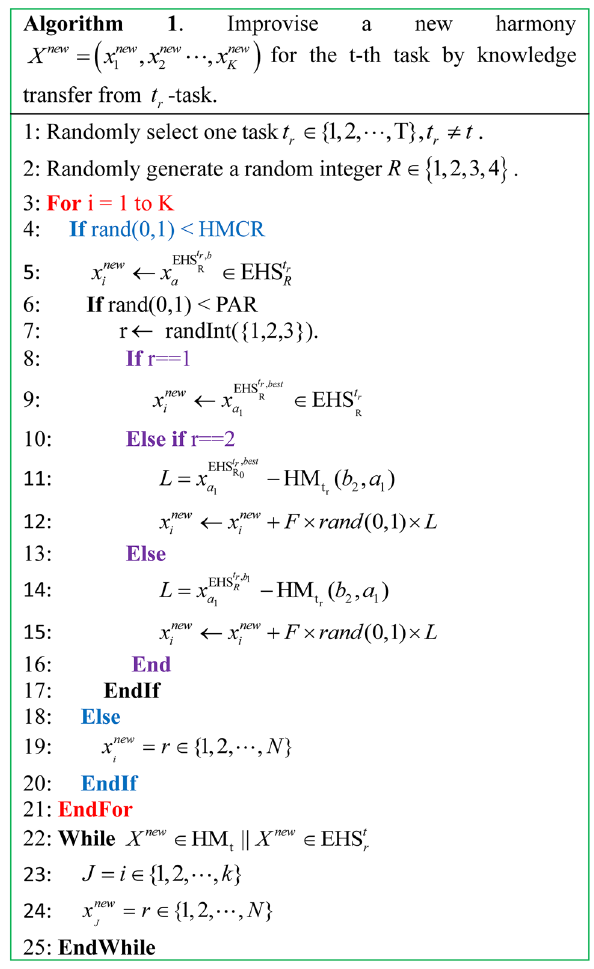
Algorithm 2 describes the steps of improvising a new har- (cid:7) (cid:6) x new for the t -th task by , x new , . . . , x new mony X new (cid:2) K 1 2 ( r (cid:2) 1, 2, 3, 4). self-learning from HM t andEHS t r In Algorithm 1 and Algorithm 2, a ∈ { 1, · · · , K } , a 1 ∈ { 1, · · · , K } , b ∈ { 1, · · · , HMS } , b ∈ { 1, 2, · · · , HMS } , 1 b 2 ∈ { 1, . . . , HMS } , R ∈ { 1, 2, 3, 4 } , R 0 ∈ { 1, 2, 3, 4 } and r ∈ { 1, 2, 3, 4 } are all randomly generated integers, and ( i , j ) denotes the j -th note (variable) of the i -th har- HM t r . EHS t is the r -th elite harmony set of the t -th mony in HM t r r t r , b task. x EHS a denotes the a -th SNP value of the b -th harmony in the r -th elite harmony set of the t -th task. F is the scale factor for adjusting the step of the local search. In Algorithm 1 and Algorithm 2, the scale factor F is important for the performance of the proposed MTHSA- DHEI method. It is analysed in the simulation experiment described in “Simulation